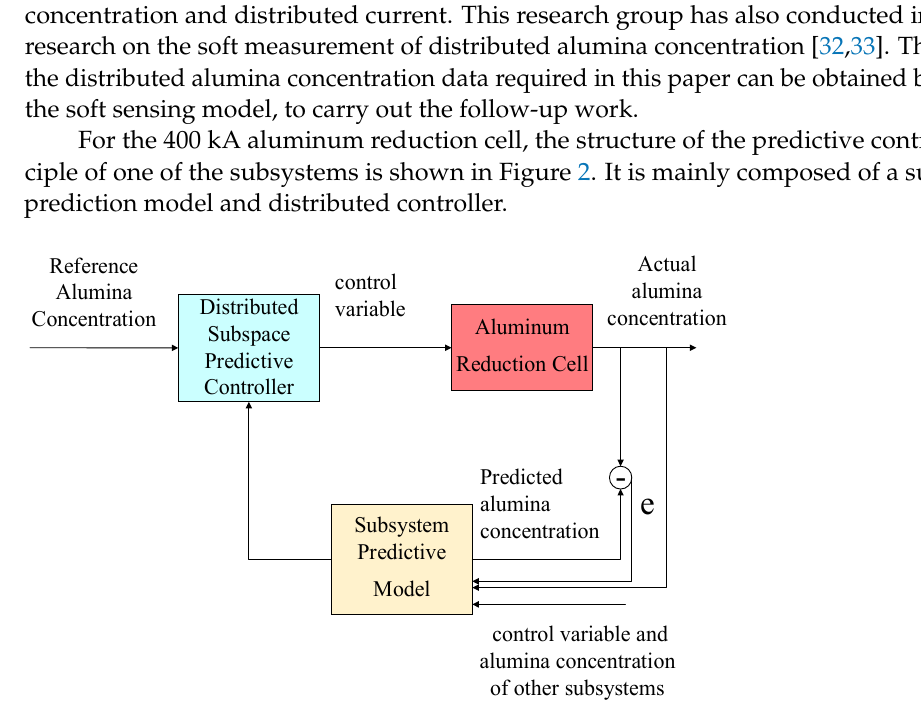
Figure 2. Predictive control diagram of aluminum electrolysis subsystem.